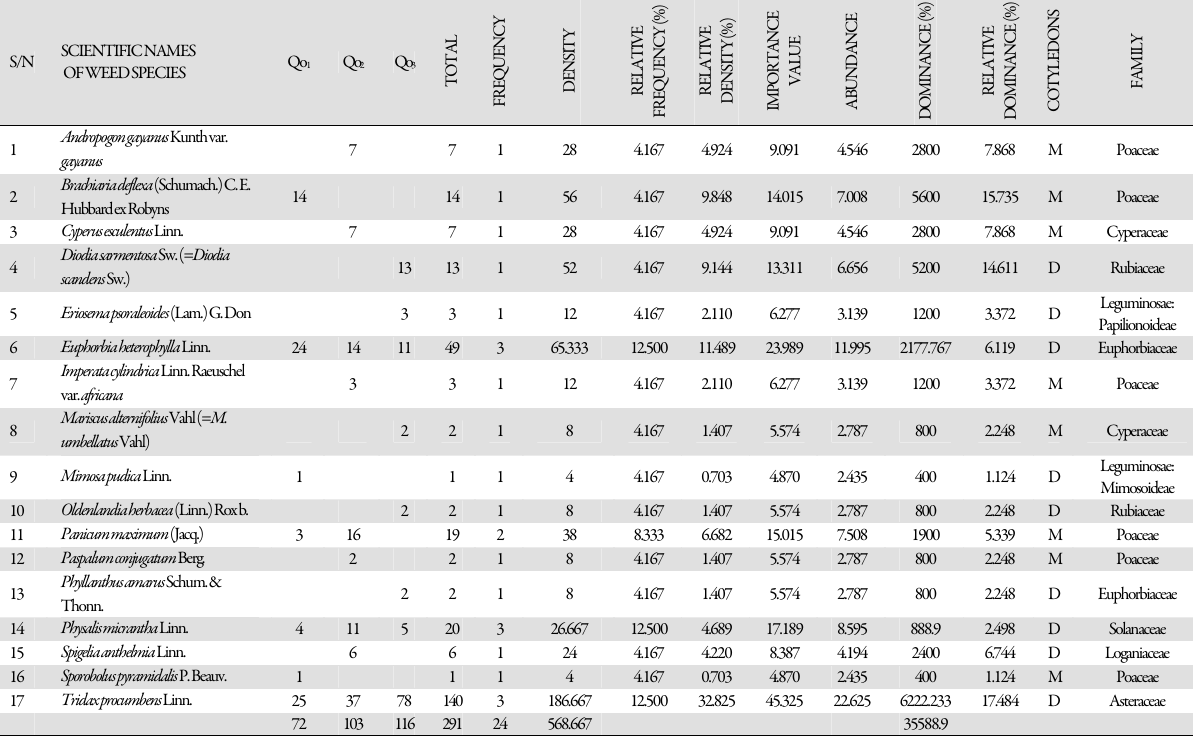
Tab. 4. Weed flora and species parameter for okra plot at 6WAP 7